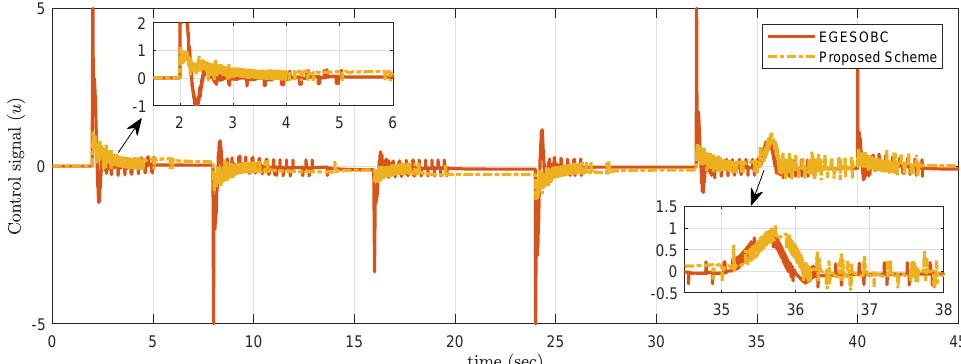
Figure 17. Experimental result of control signal for controlling θ .